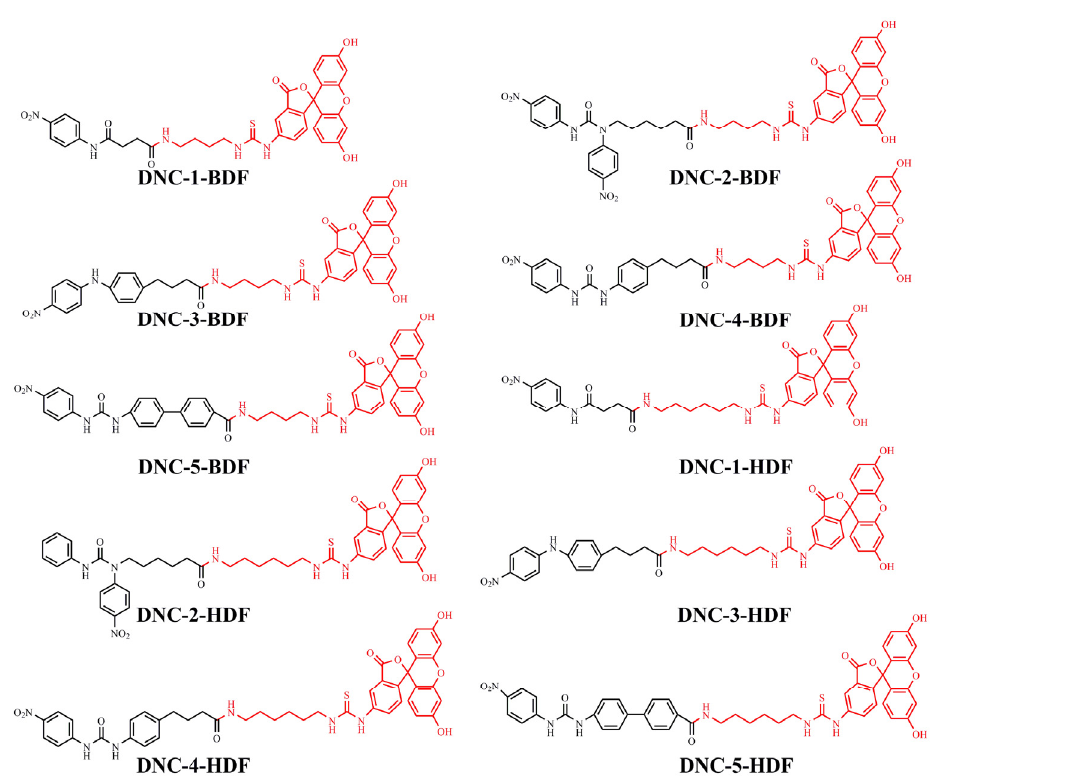
Figure 1. Structures of 25 different tracers of DNC.